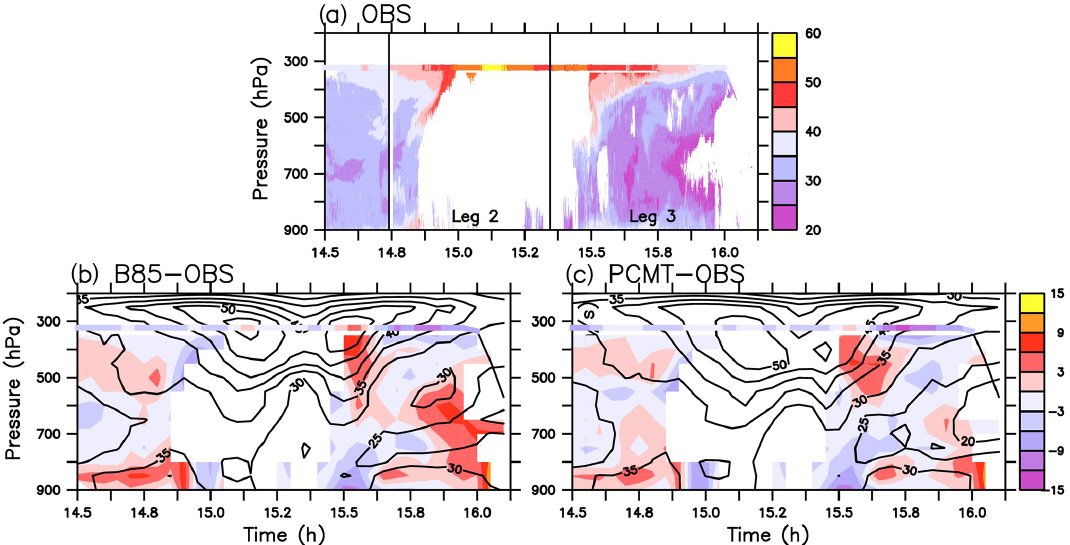
Figure 11. (a) Wind speed observations from RASTA and aircraft at full resolution. Wind speed anomaly with respect to observations interpolated at model resolution (shading) and wind speed (black contour) for B85 ( b difference B85-Obs.) and PCMT ( c difference PCMT-